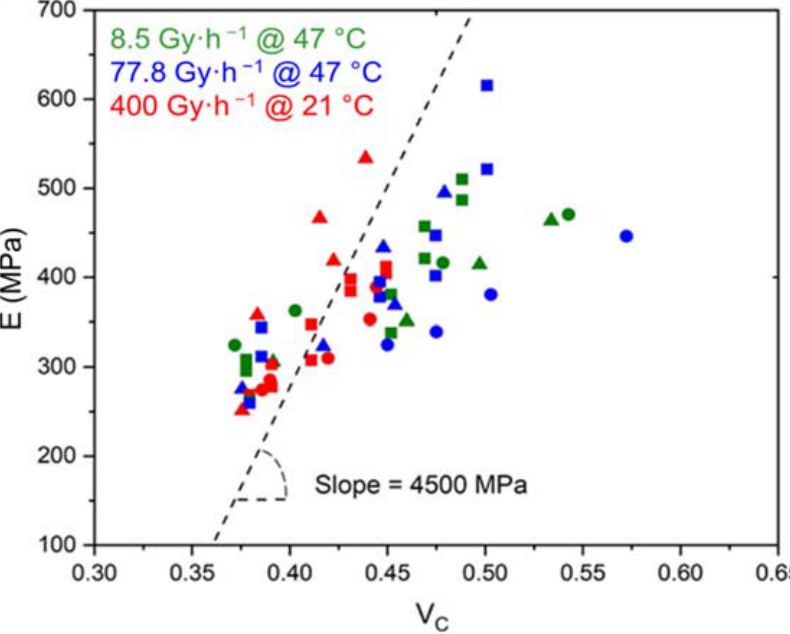
Figure 15. Elastic modulus versus volume fraction of crystals for the Si ‐ XLPE matrix filled with 0 phr ( □ ), 25 phr ( ), and 50 phr ( ) of ATH, during its radio ‐ thermal exposure in air under 8.5 Gy ∙ h − 1 at 47 °C (green), under 77.8 Gy ∙ h − 1 at 47 °C (blue), and under 400 Gy ∙ h − 1 at 21 °C (red).